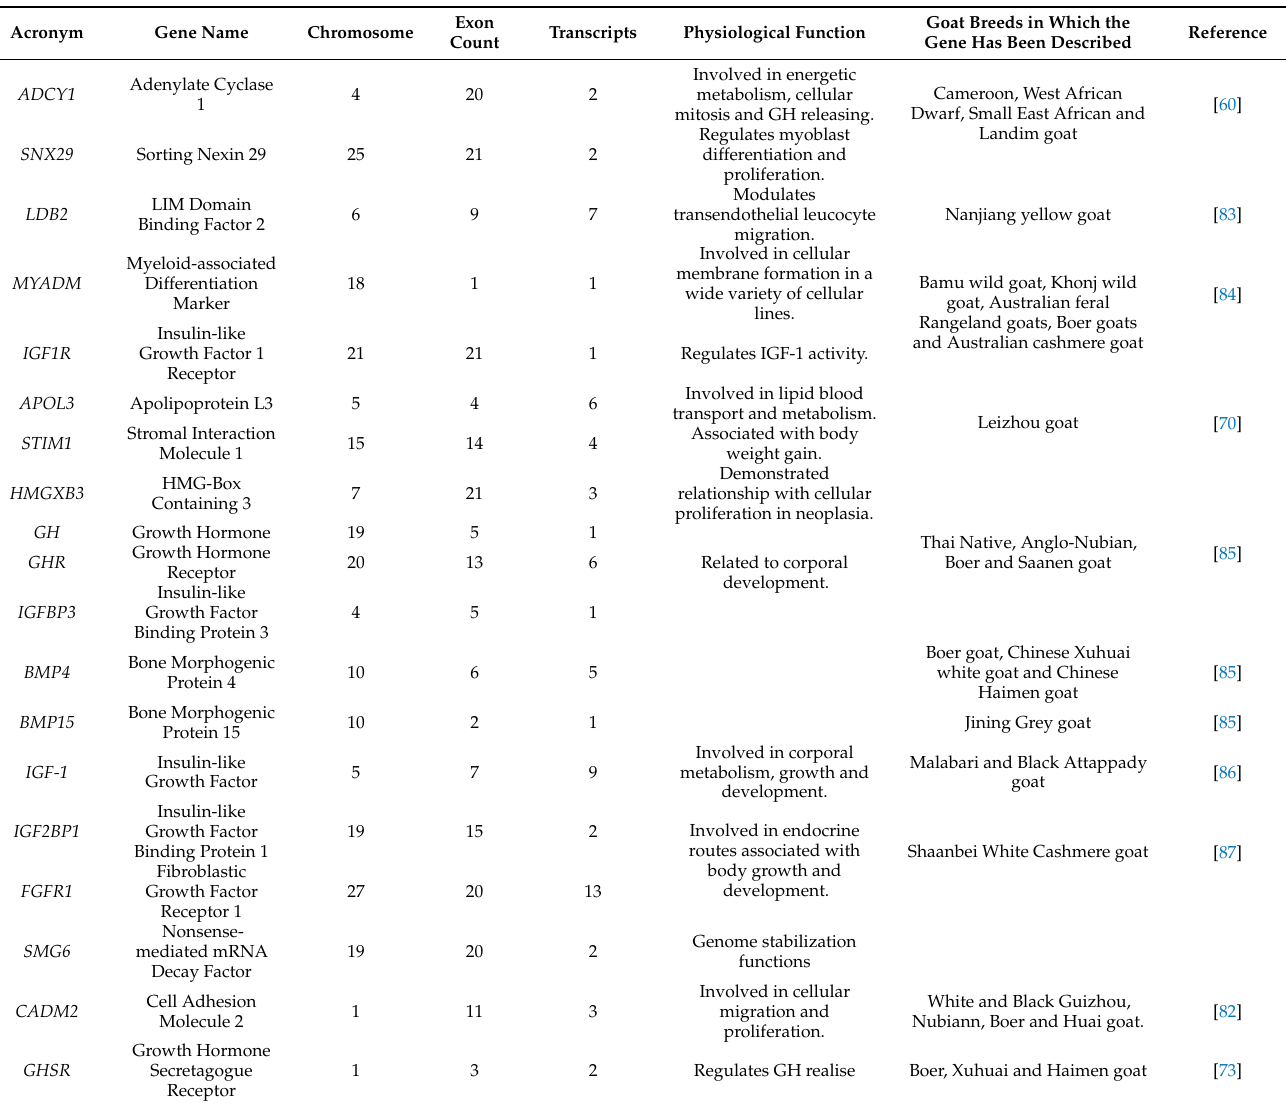
Table 2. Summary of the candidate genes associated with body growth and weight gain that have been described in goat breeds, their chromosome location, exon counts, physiological function and where to find them in the